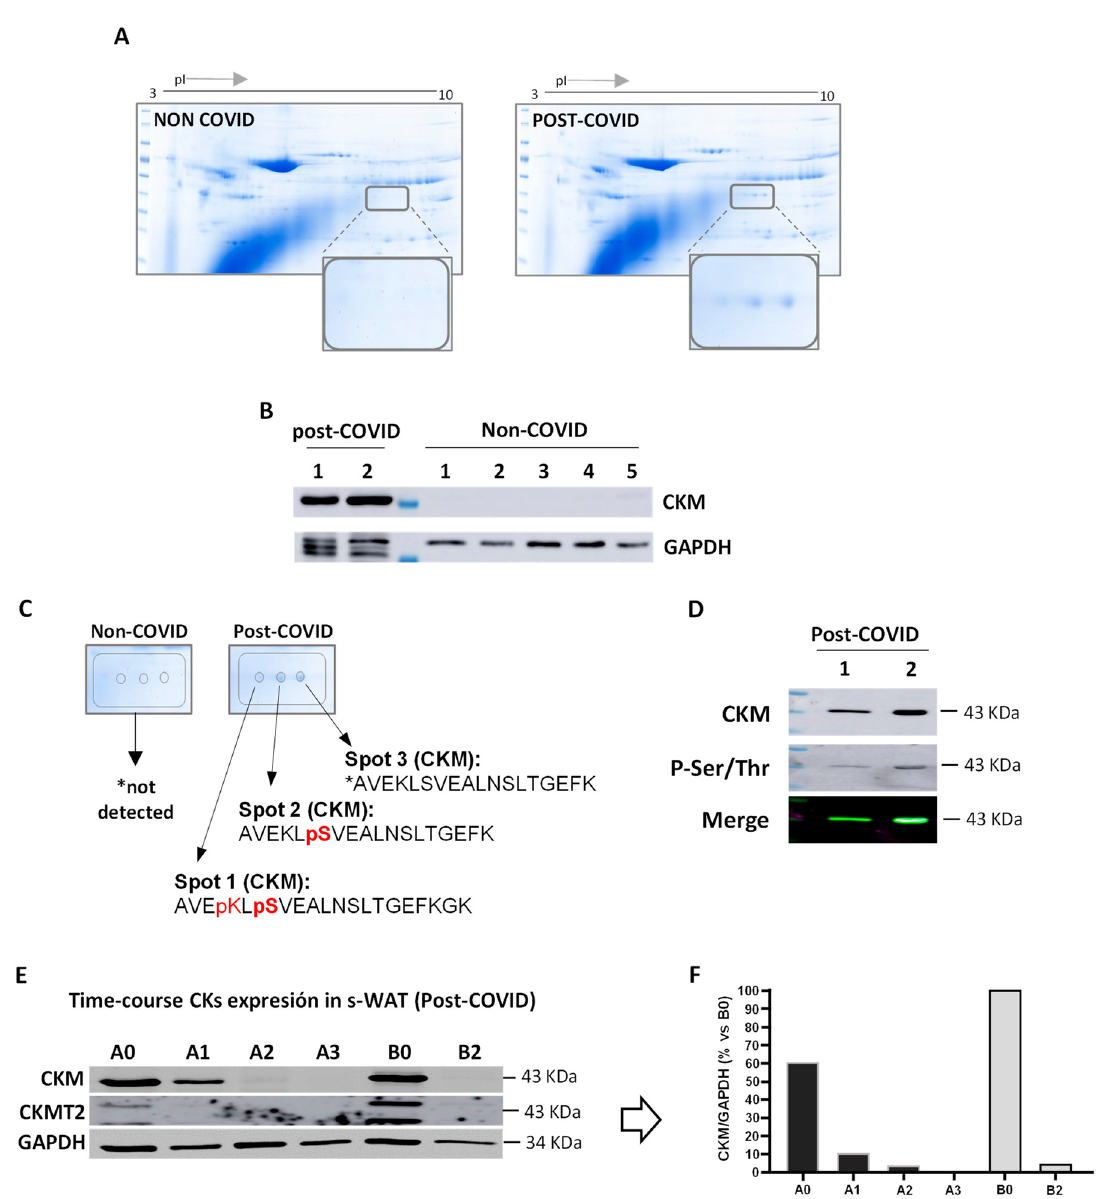
Figure 3. Proteomic analysis. ( A ) Representative 2D gels of s-WAT proteomes. The samples were analyzed in groups: s-WAT proteins from COVID-19-negative, pre-pandemic patients (non-COVID) and COVID-19-positive, post-pandemic patients (post-COVID). The inset shows the points (spots) extracted and analyzed. ( B ) Western blot of the MM isoforms of creatine kinase. GAPDH was used as load control. ( C ) Comprehensive analysis of the identified peptides shows the presence of post-translational modifications in lysine and serine residues. ( D ) Western blot confirming the presence of phosphorylation in serine residues. ( E , F ) Persistence of CKM and CKMT2 over time. ( E ) WB of CKM and CKMT2 from s-WAT of two post-COVID patients (A and B) at different periods of time. A0 and B0, first surgery; A1, surgical intervention approximately one month later; A2 and B2, surgical intervention approximately two months later. ( F ) Representative graph of the CKM and CKMT2 levels corrected by GAPDH and relativized to all highest values (B0).